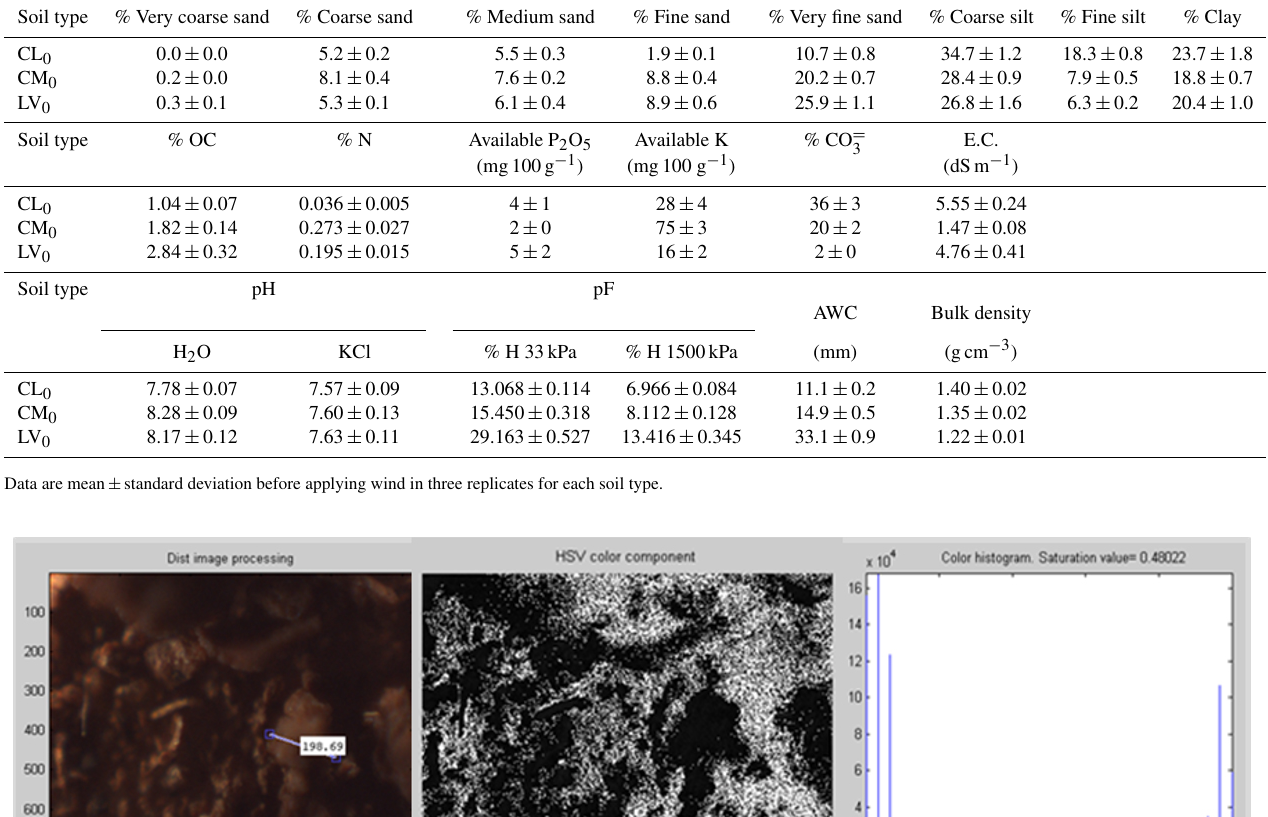
Table 1. Initial soil characteristics for Calcisols (CL 0 ) , Cambisols (CM 0 ) and Luvisols (LV 0 ) tested (OC: organic carbon; AWC: available water content).